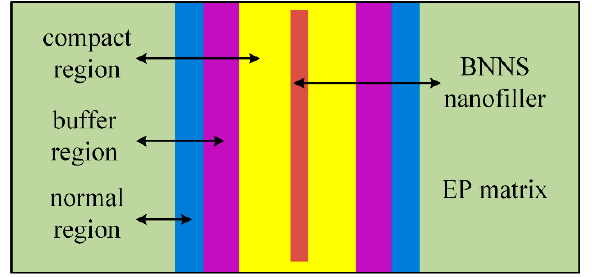
Figure 12. Multiregional interface model.